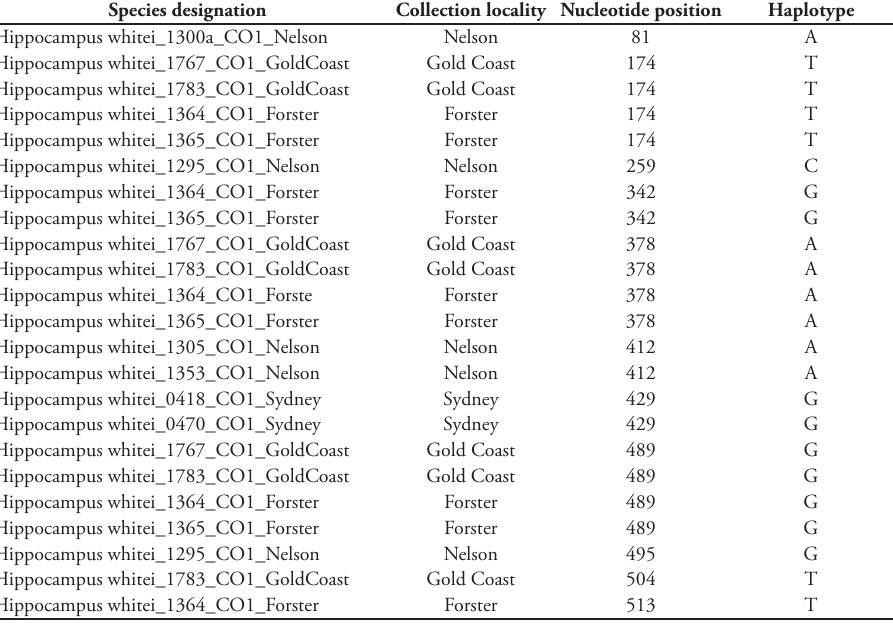
Table 5. Distribution of haplotypes based on partial mtDNA COI sequence data (655 bp) tabulated across sampled H. whitei and localities in central NSW and southern QLD.